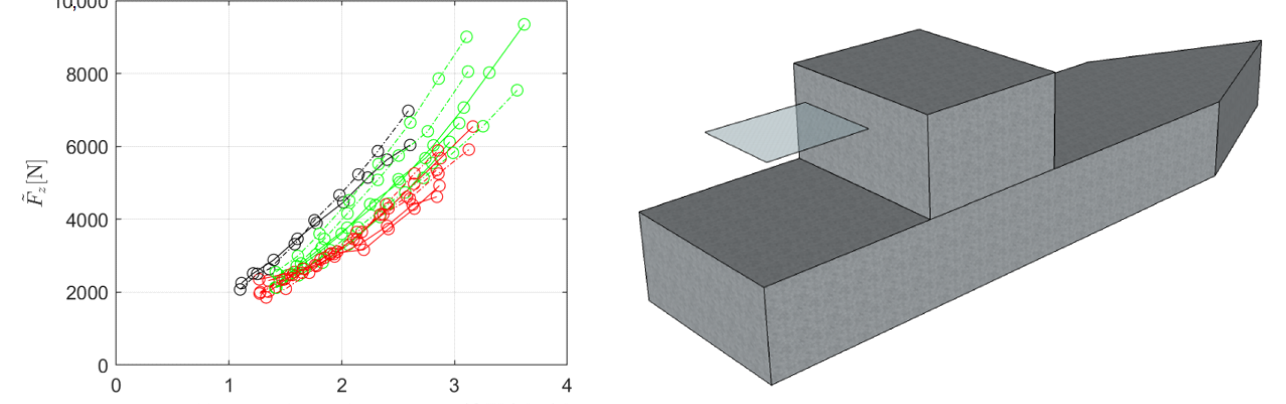
Figure 9. Relationship between unsteady loads and computed turbulence on rotor disc planes; each line represents a wind speed, line type for different rotor positions, and line colour for directions.